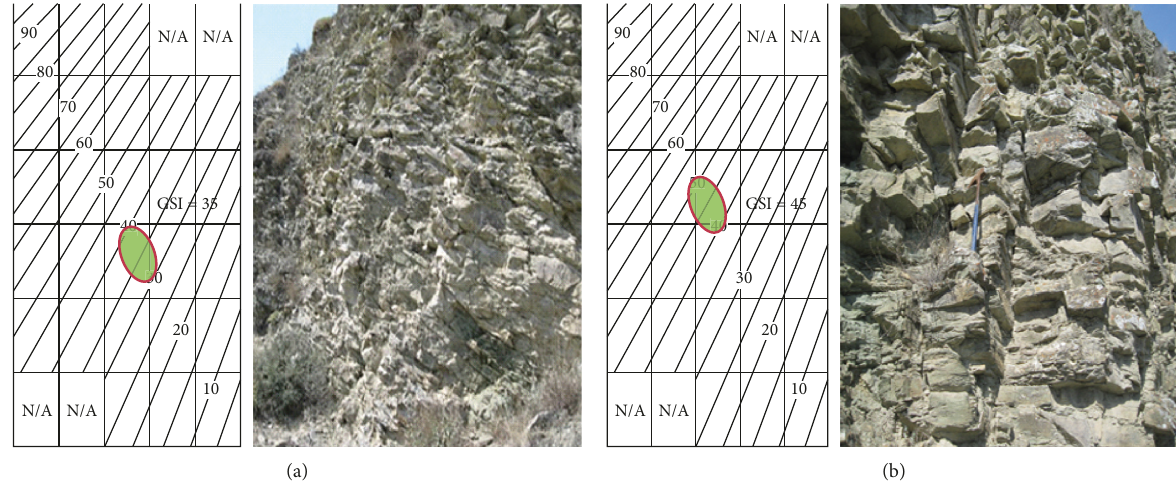
Figure 3: GSI measuring at two geological stations: (a) completely disintegrated rock mass and (b) blocky structure, Hoek et al.